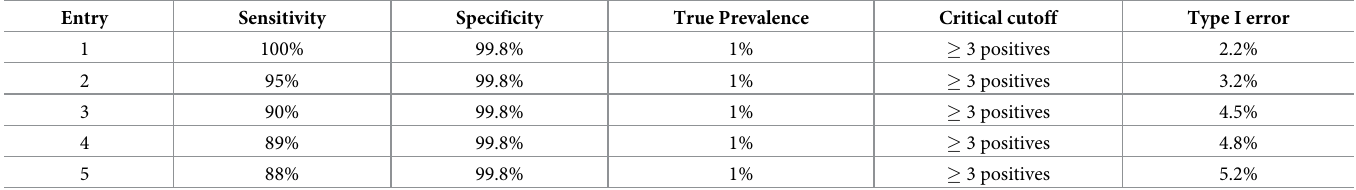
Table 8. Effect of sensitivity on the Type I error when treatment decisions are based on the cluster-specific results, assuming 30 clusters are surveyed and 100 chil- dren/cluster. A specificity of 99.8% was assumed. The critical cutoff was � 2 positive tests in at least 1 village. The calculations were made for a true prevalence of 1%. At least 89% sensitivity is required to have a Type I error of <